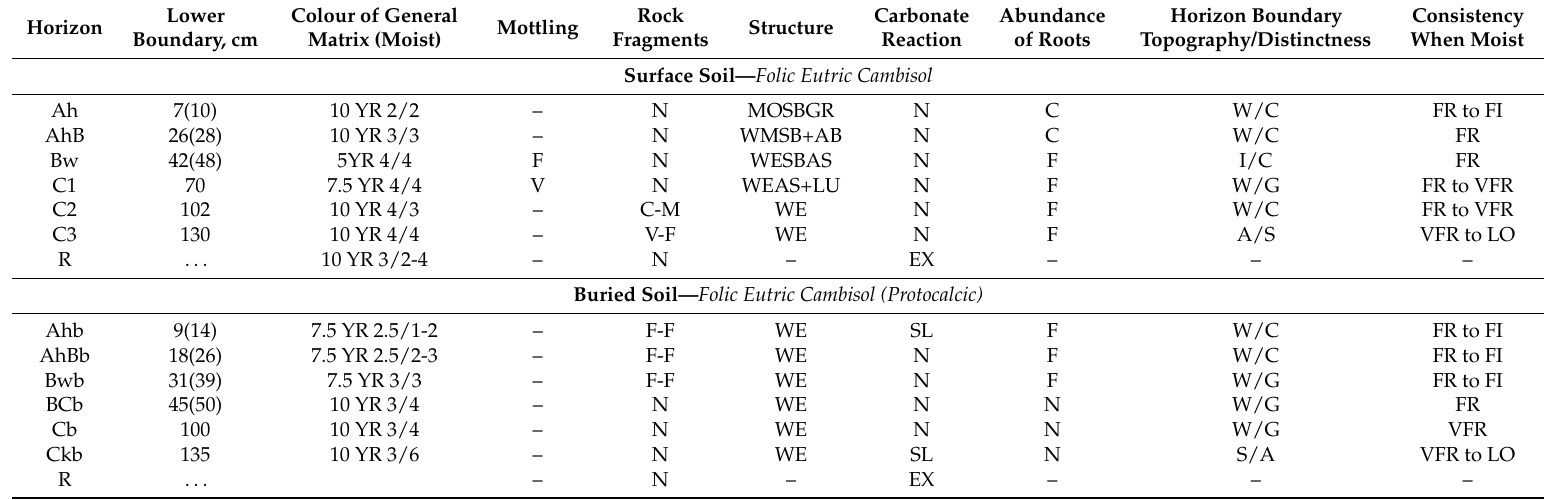
Table 1. Field description of the studied